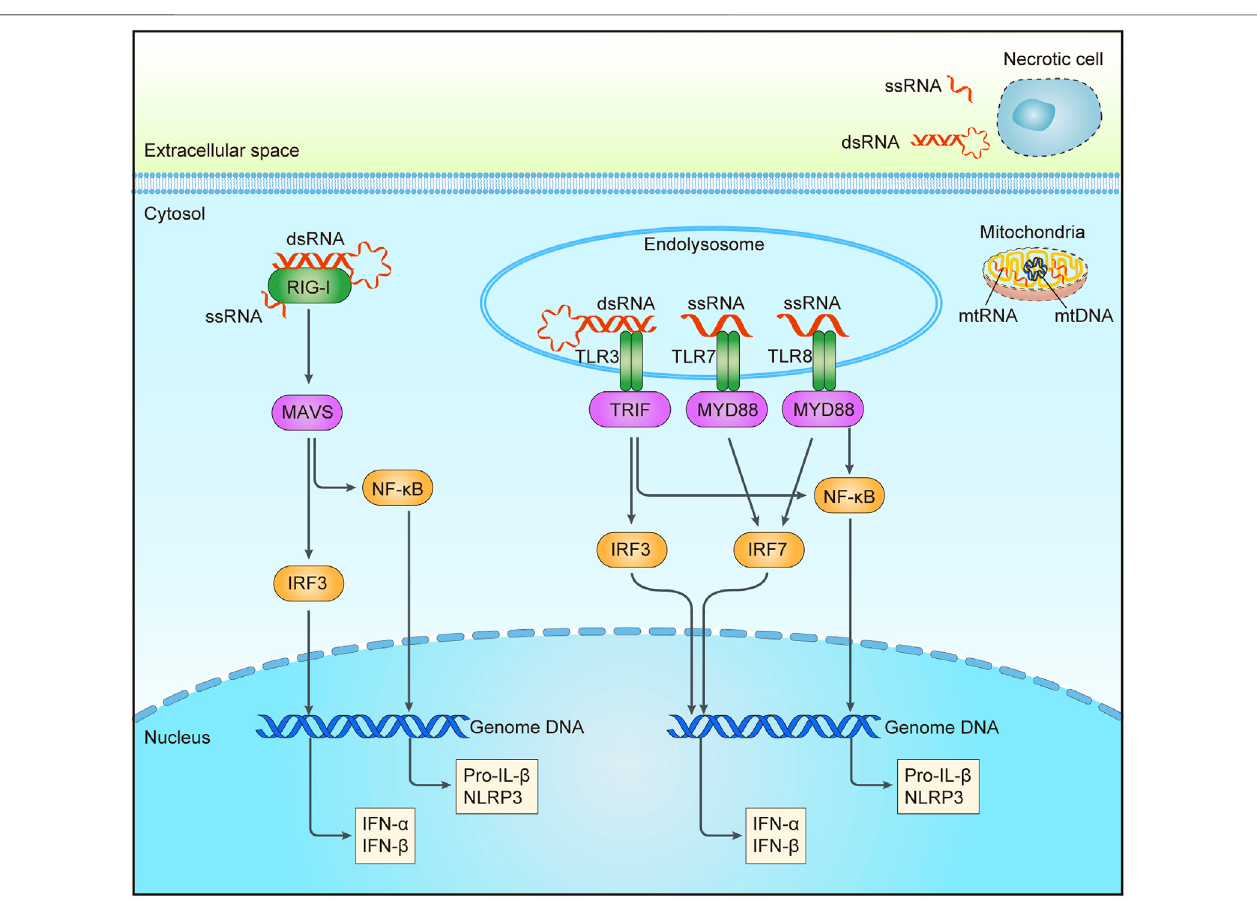
FIGURE2| RNAsensingpathways triggered byDNAdamage.Aberrantincreaseofintracellular RNAcouldbefrom mitochondria after chemotherapy orradiation. RNA in endosomal may be from extracellular RNA of necrotic cells through endocytosis or cytoplasmic RNA through autophagy. Sensors for RNA are shown in green, including RIG-1 in the cytoplasm, and TLR3/7/8 in the endolysosome. Adaptor molecules are shown in pink and downstream signaling molecules are shown in yellow. Activation of these pathways may result in the production of interferon (IFN) and other cytokines, etc. RIG-I, a retinoic acid-inducible gene I; TLR3/7/8, Toll-like receptor 3/7/8; MAVS, mitochondrial antiviral signaling protein; TRIF, Toll-like receptor adaptor molecule 1; MYD88, myeloid differentiation primary response protein 88; IRF3/7, interferon regulatory factor 3/7; NF- κ B, nuclear factor- κ B; dsRNA, double stranded RNA; ssRNA, single stranded RNA; mtRNA, mitochondrial RNA; mtDNA, mitochondrial